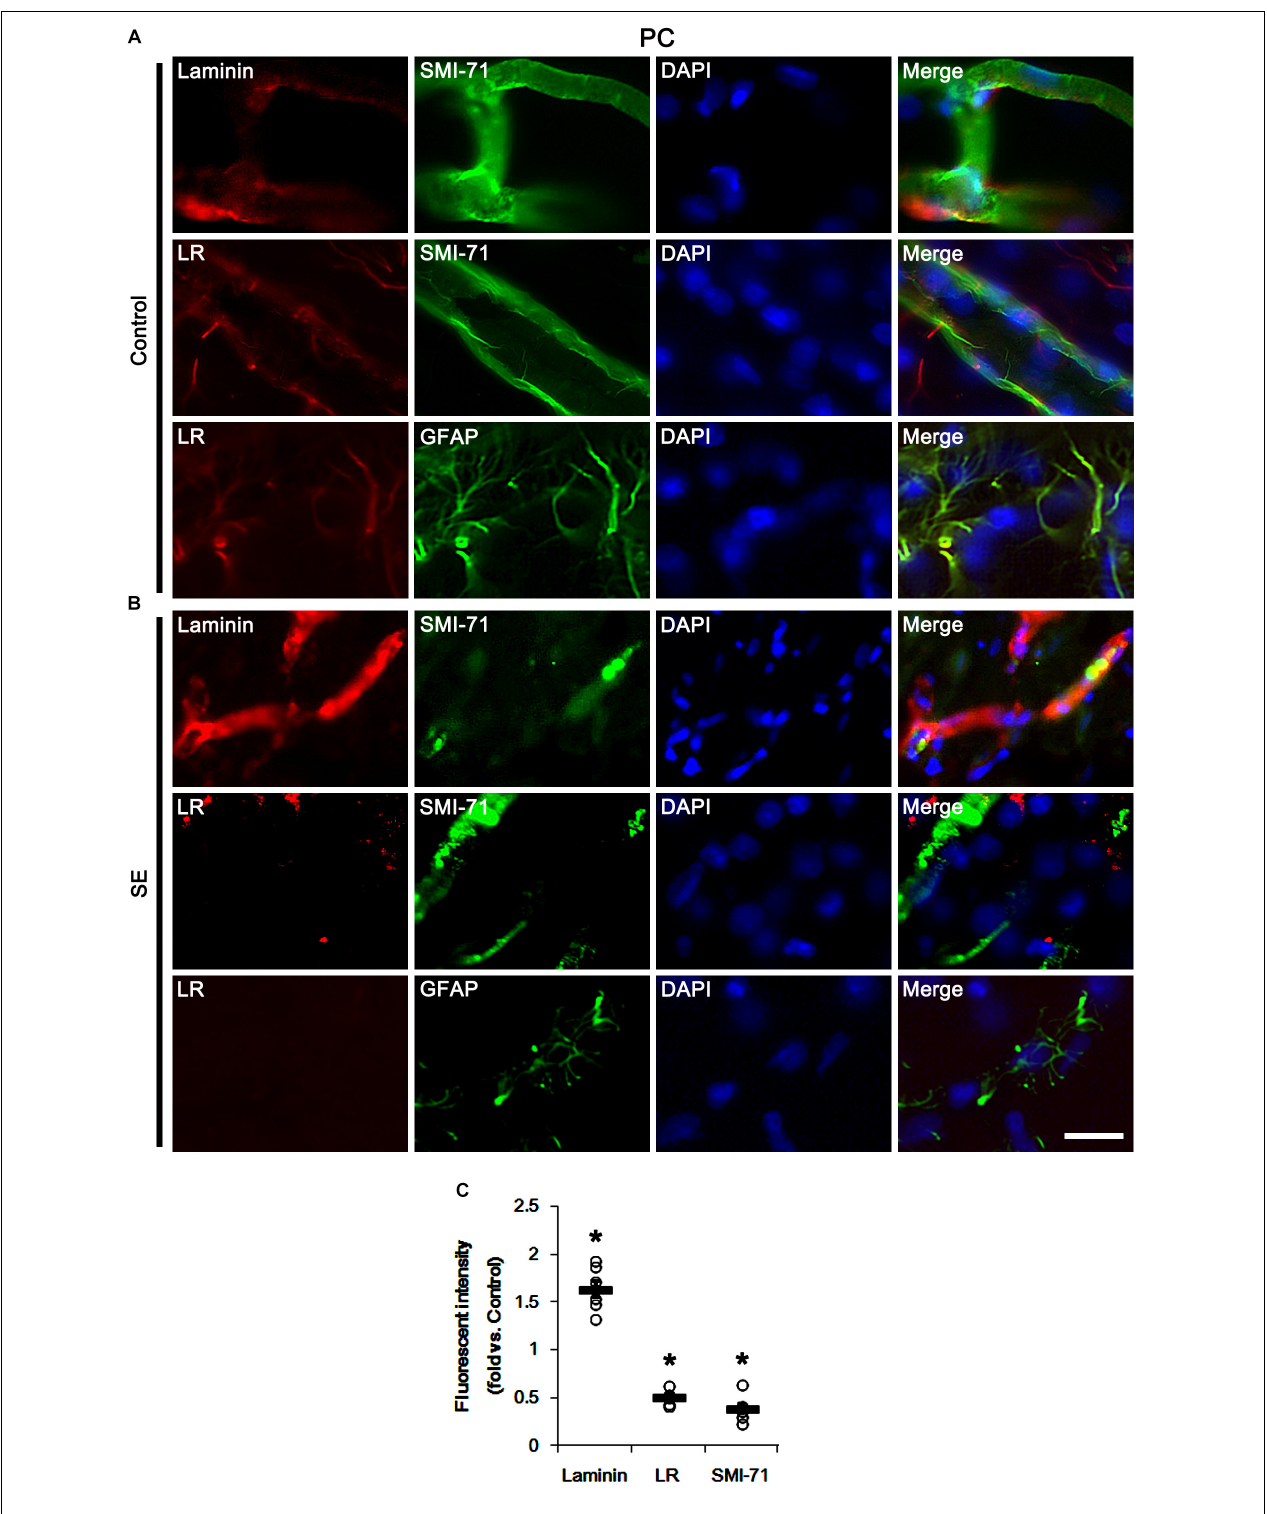
FIGURE 2 | Alterations in laminin and 67-kDa LR (LR) expression in capillaries and astrocytes within the PC following SE. (A,B) Representative photographs of SMI-71, laminin and 67-kDa LR expression in control (A) - and post-SE animals (B) . SE increases laminin expression, but reduces 67-kDa LR expression, accompanied by BBB disruptions (SMI-71 degradation) in capillaries. SE also diminished astroglial 67-kDa LR expression. Bar = 12.5 µ m. (C) Quantitative values (mean ± S.E.M) of the fluorescent intensities of laminin, 67-kDa LR and SMI-71 ( n = 7, respectively). Open circles indicate each individual value. Horizontal bars indicate mean value. Significant differences are ∗ p < 0.05 vs. control animals (Student t -test).